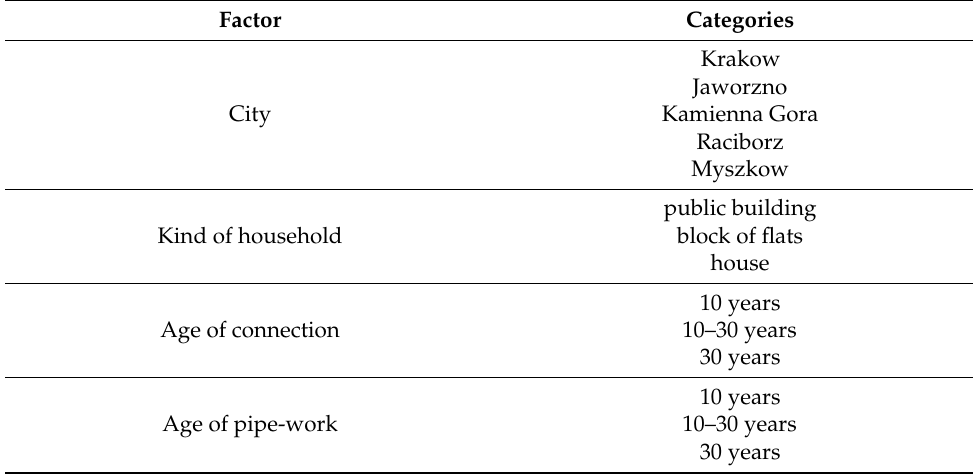
Table 3. Categories established for survey descriptive variables collected during the field